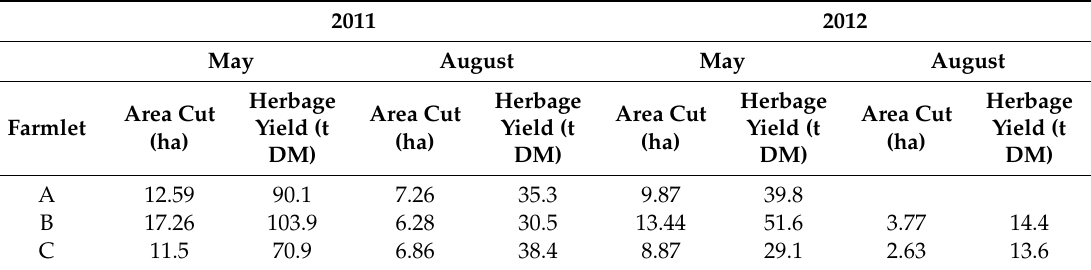
Table 3. Yield of herbage cut for silage on May and August 2011 and 2012.